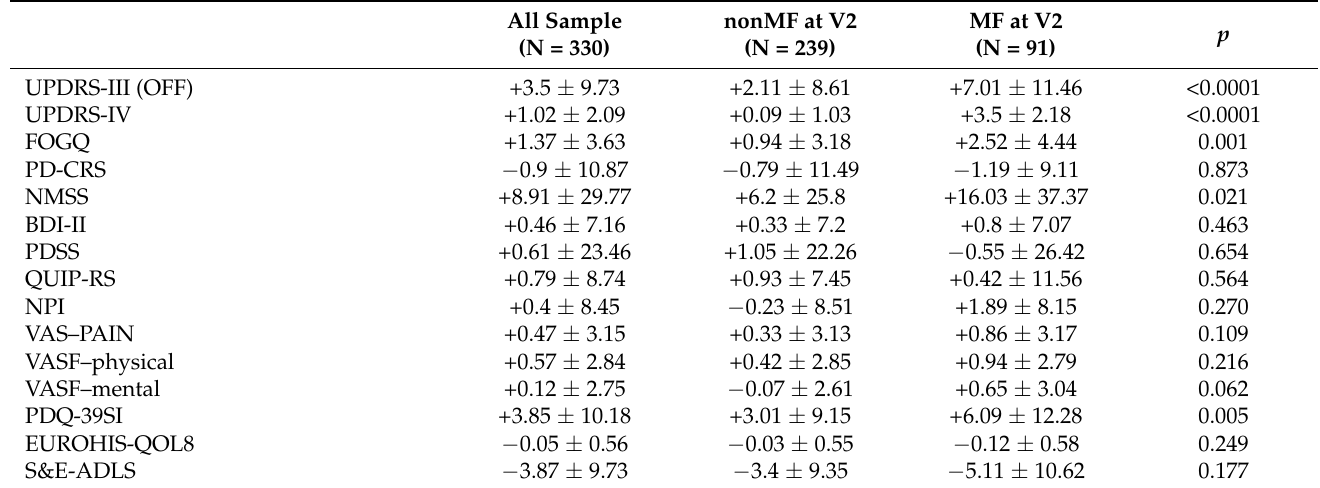
dose; N, number; NMSS, Non-motor Symptoms Scale; NPI, Neuropsychiatric Inventory; PD-CRS, Parkinson’s Disease Cognitive Rating Scale; PDSS, Parkinson’s Disease Sleep Scale; QUIP-RS, Ques- tionnaire for Impulsive–Compulsive Disorders in Parkinson’s Disease-Rating Scale; TS, total score; UPDRS, Unified Parkinson’s Disease Rating Scale; VAFS, Visual Analog Fatigue Scale; VAS–Pain, Visual Analog Scale–Pain.